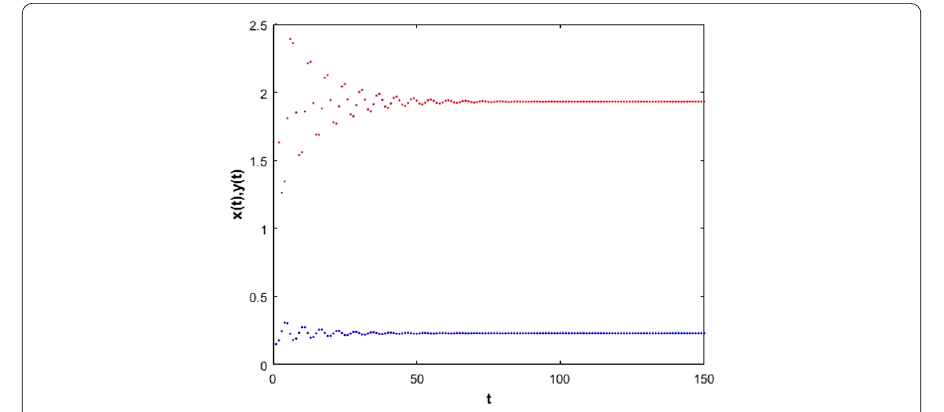
Figure 1 A stable fixed point for the system (2) for a = 2.5, m = 0.25, β = 0.23 and initial condition ( x 0 , y 0 ) =